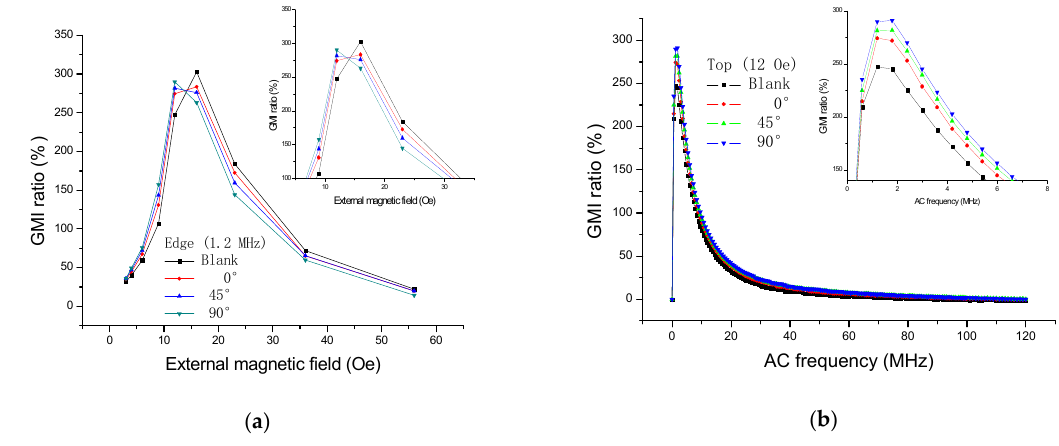
Figure 9. The giant magnetoimpedance responses when the ribbon (3 × 5 mm 2 ) is detected in front of the sensor II with different angles (0°, 45°, 90°): ( a ) field dependence and ( b ) frequency dependence. We have also measured the GMI response when the ribbons are, respectively, tested on the left and at the back of the GMI sensor II, respectively, as shown in Figure 10. It is clear from Figure 10a that the GMI curve moves to a lower magnetic field due to the presence of the ribbon at the back of